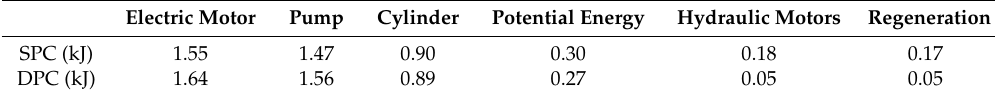
Table 5. Energy consumption and regeneration of the SPC and